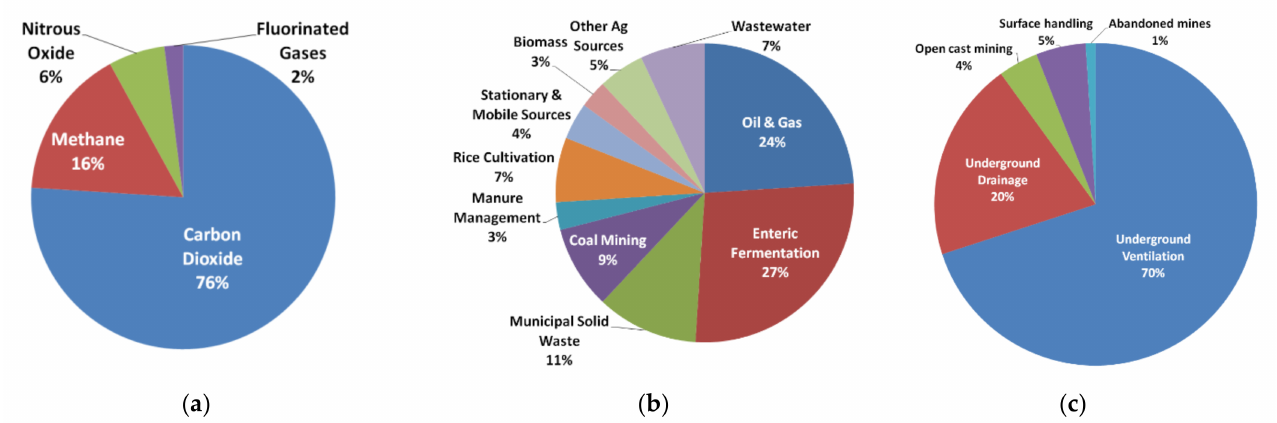
Figure 1. ( a ) Global greenhouse gas emissions by gas [9]. ( b ) Global methane emissions by sector [10]. ( c ) Methane emissions from coal mining by